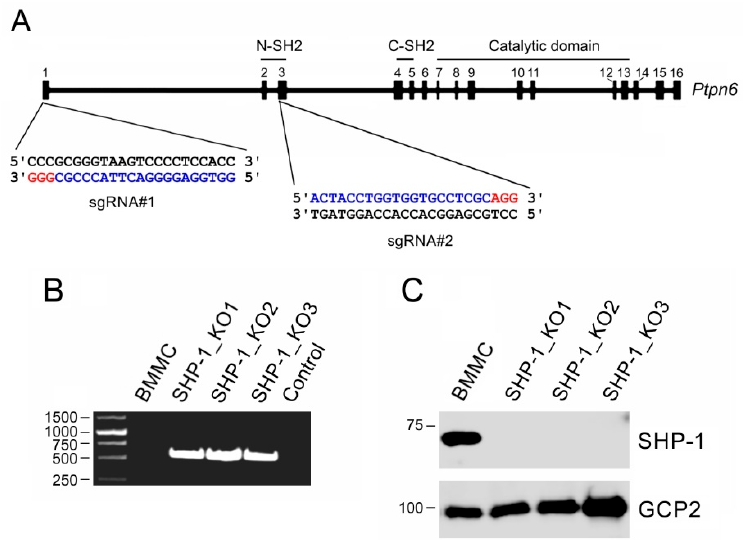
Figure 4. The generation of SHP-1 deficient cell lines. ( A ) A schematic diagram of Ptpn6 with sites targeted by guide RNA (sgRNA) sequences: The targeted sites (blue) and protospacer-adjacent motifs (PAM; red) on the gene (18.01 kb) containing 16 exons are shown. The defined domains are indicated. ( B ) The PCR amplification of genomic DNA from the control cells (BMMC) and SHP-1-deficient cell lines (SHP-1_KO1, SHP-1_KO2, SHP-1_KO3) with primers flanking the deleted region: The template is not present in the control sample. Due to the large size of the deleted region (approx. 6 kb), no amplification was found in the control BMMCs. The amplification of short fragments (approx. 560 bp) was detected in SHP-1-deficient clones. ( C ) The SHP-1 protein levels in BMMCs and SHP-1-deficient cell lines analyzed by an immunoblotting of whole-cell lysates: GCP2 served as the loading control.